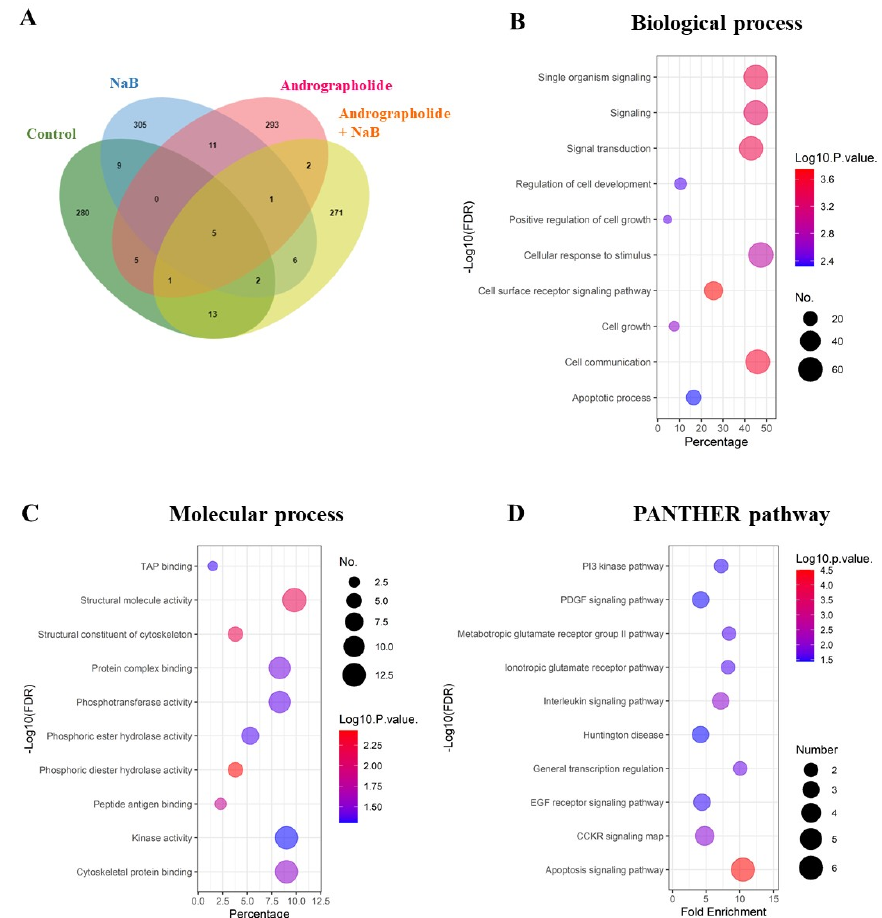
Figure 2. Andrographolide treatment modulates host gene expression in EBV-infected cells and functional annotation of proteins in cells with EBV lytic activation condition. ( A ) The unique proteins were visualized using a Venn diagram. ( B ) The functional annotation was determined in two aspects: biological processes; ( C ) molecular function by PANTHER. ( D ) The biological pathways were involved with up-regulated